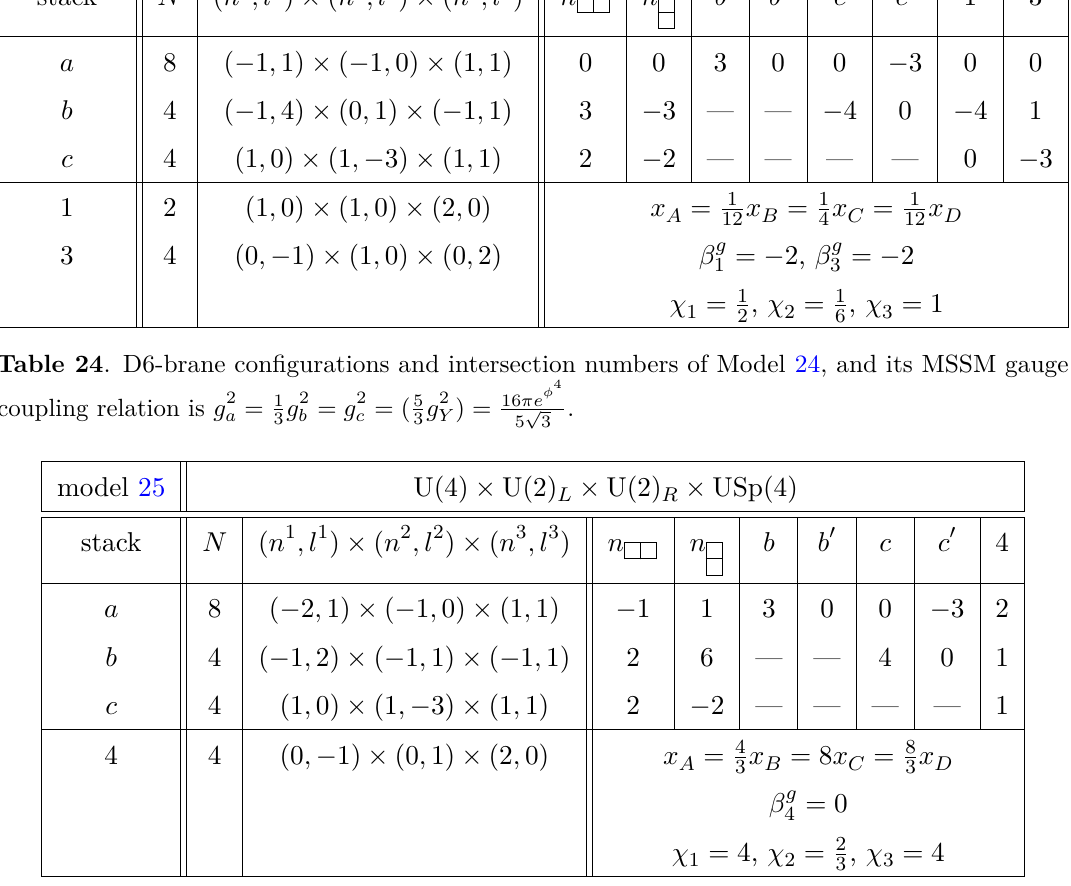
Table 25 . D6-brane configurations and intersection numbers of Model 25, and its MSSM gauge